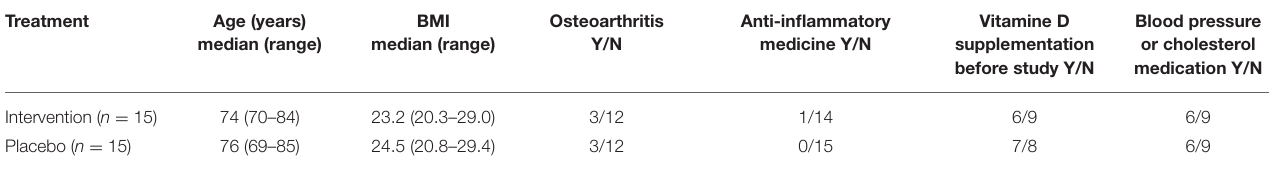
TABLE 1 | Characteristics of study participants.